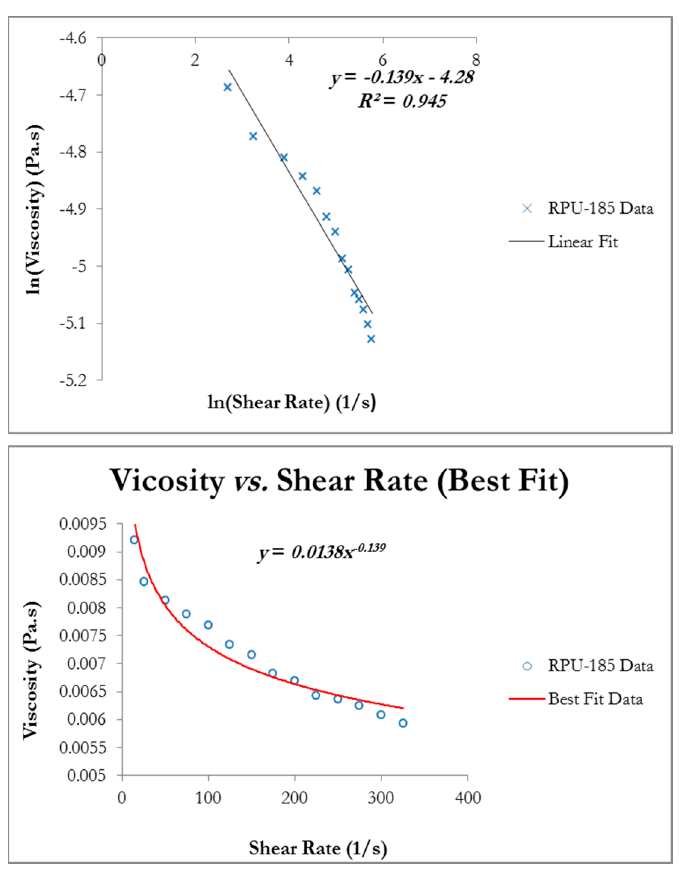
Figure 4. Viscosity plotted against shear rate for rotating MBR system RPU-185.